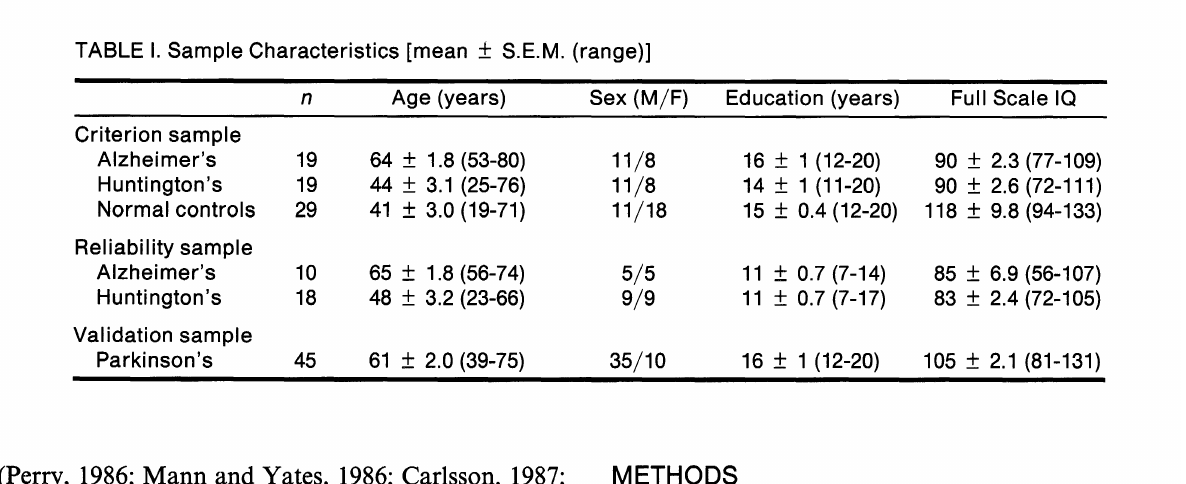
TABLE I. Sample Characteristics [mean ± S.E.M.